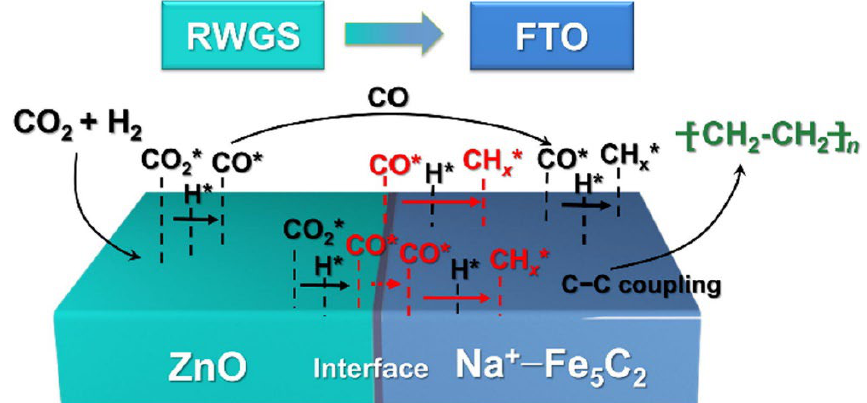
Figure 7. Reaction mechanism for CO 2 hydrogenation to olefins over the Na–Zn–Fe catalyst. Reprinted with permission from ref. [68] . Copyright 2021 Elsevier.